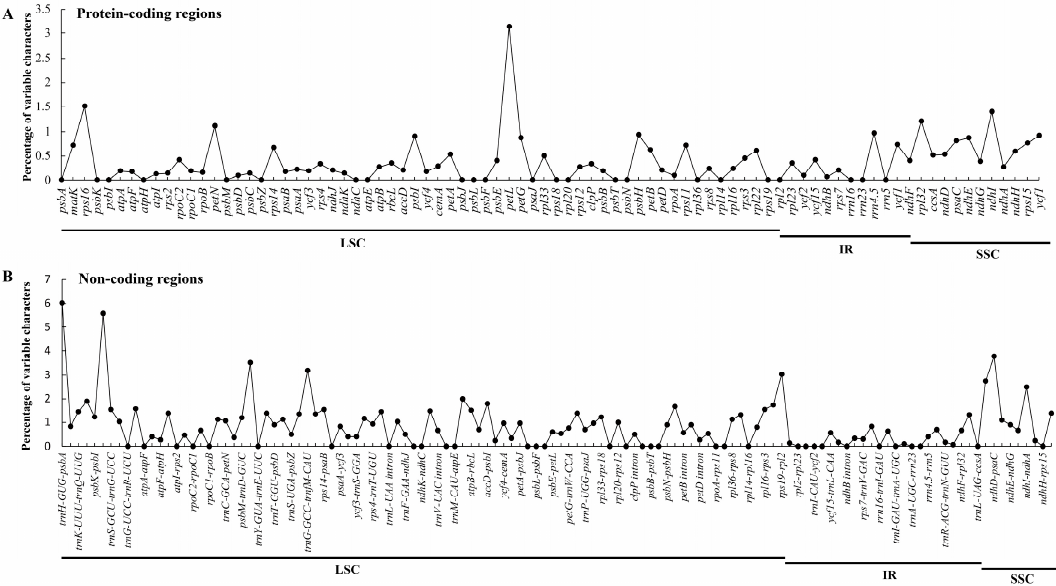
Figure 5. Percentage of variable characters in eight aligned chloroplast genomes of Gentiana sect. Cruciata . ( A ) Coding region; ( B ) Noncoding region.